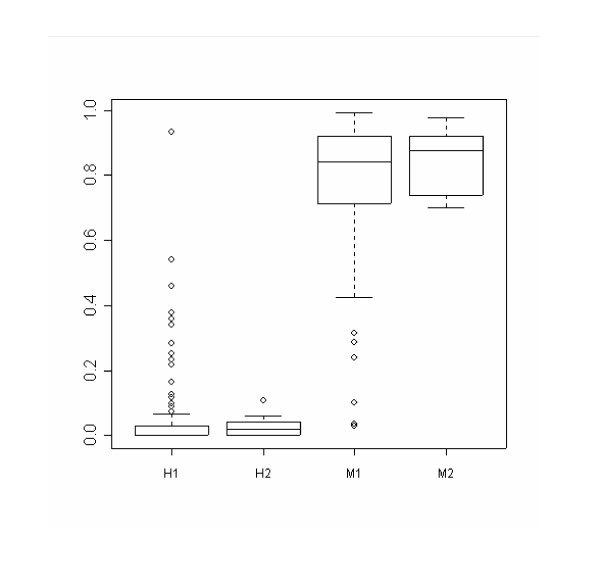
Detection p-values for a sample probe set (38249_at). H1 and H2 denote the detection p-values in normal and lung cancer groups, respectively, for the Harvard study; whereas M1 and M2 denote the detection p-values in normal and lung cancer groups, respectively, for the Michigan study.